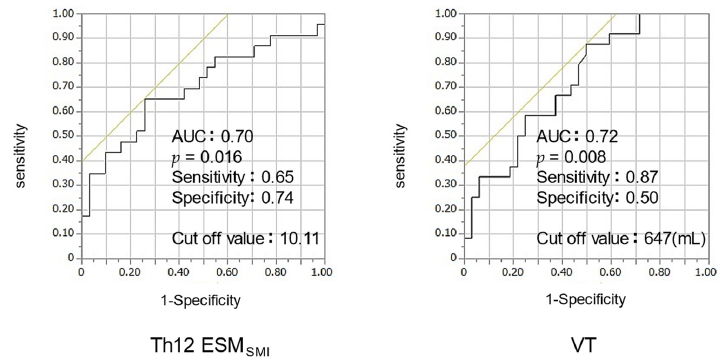
Figure 3. ROC analysis of Th12 ESM SMI , VT for energy malnutrition. Abbreviation: ROC—receiver operating characteristic, Th12 ESM SMI —skeletal muscle index of Th12 Erector Spinae muscles;